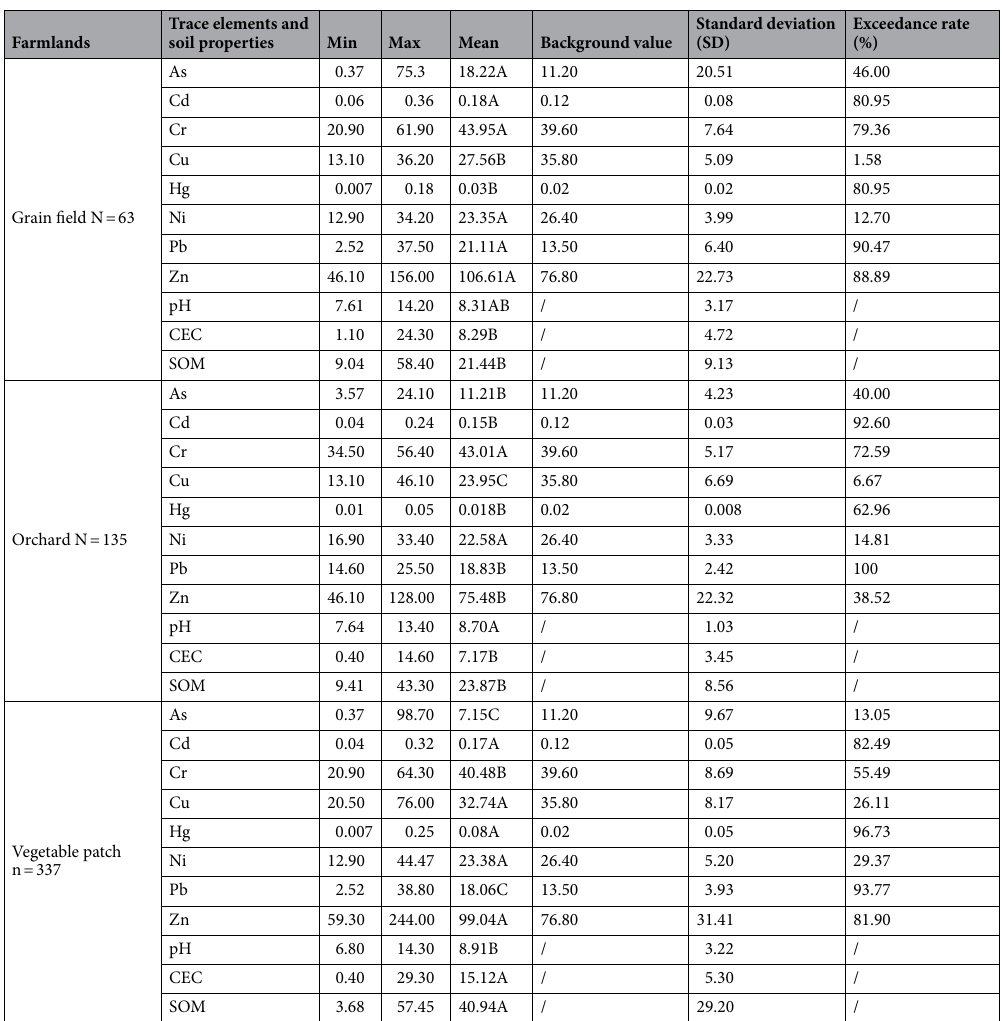
Table 1. Statistical analysis of eight trace elements (mg·kg −1 ) and soil properties (pH; CEC, cmol(+)·kg −1 ; and SOM, g·kg −1 ) in three farmland soils. The different capital letters after the Mean values indicate a significant difference ( p < 0.05) in trace element content or soil properties among the three farmlands using One-way ANOVA, whereas same capital letters show no significant differences ( p > 0.05). Soil properties had no background values thus “/” are used in the table